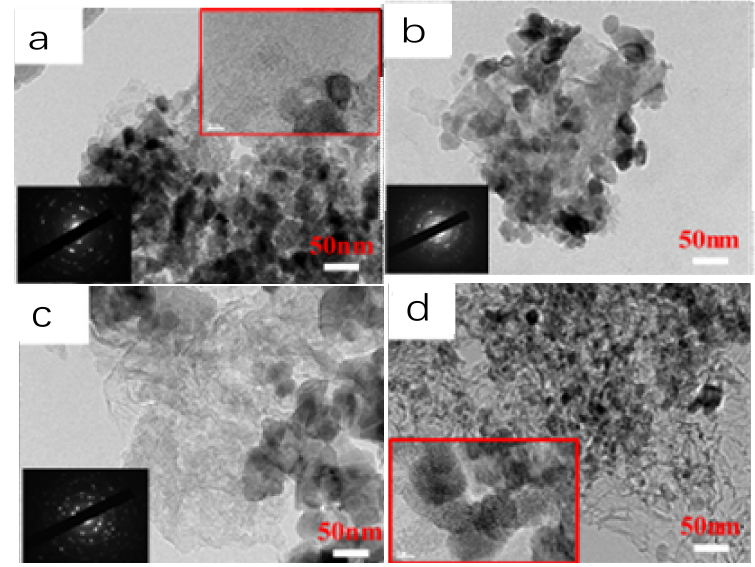
Figure 7. TEM images of ( a ) SrF 2 @C, ( b ) SrF 2 @NC, ( c ) SrF 2 @C-700, and ( d ) SrF 2 @NC-700.